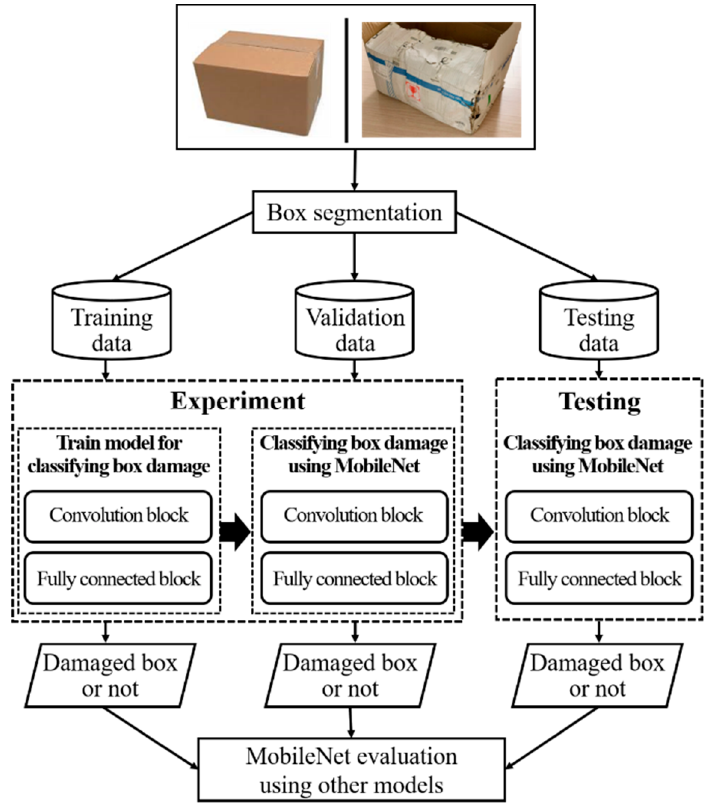
Figure 7. Framework research classifying the parcel boxes.